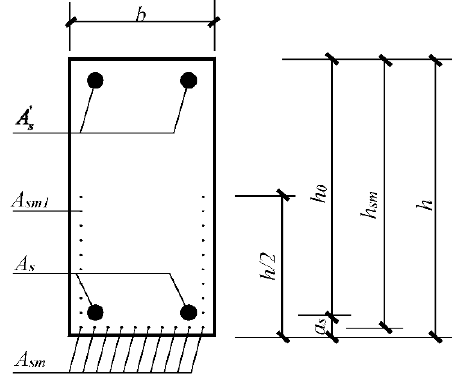
Figure 16. Component cross